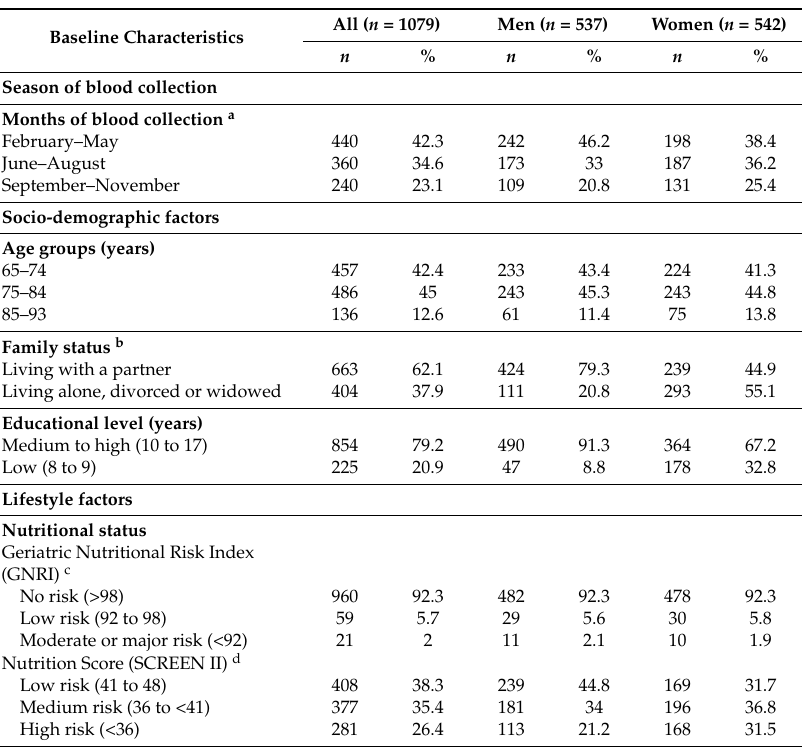
Table 1. Baseline characteristics of older adults in KORA-Age 2008/2009, stratified by